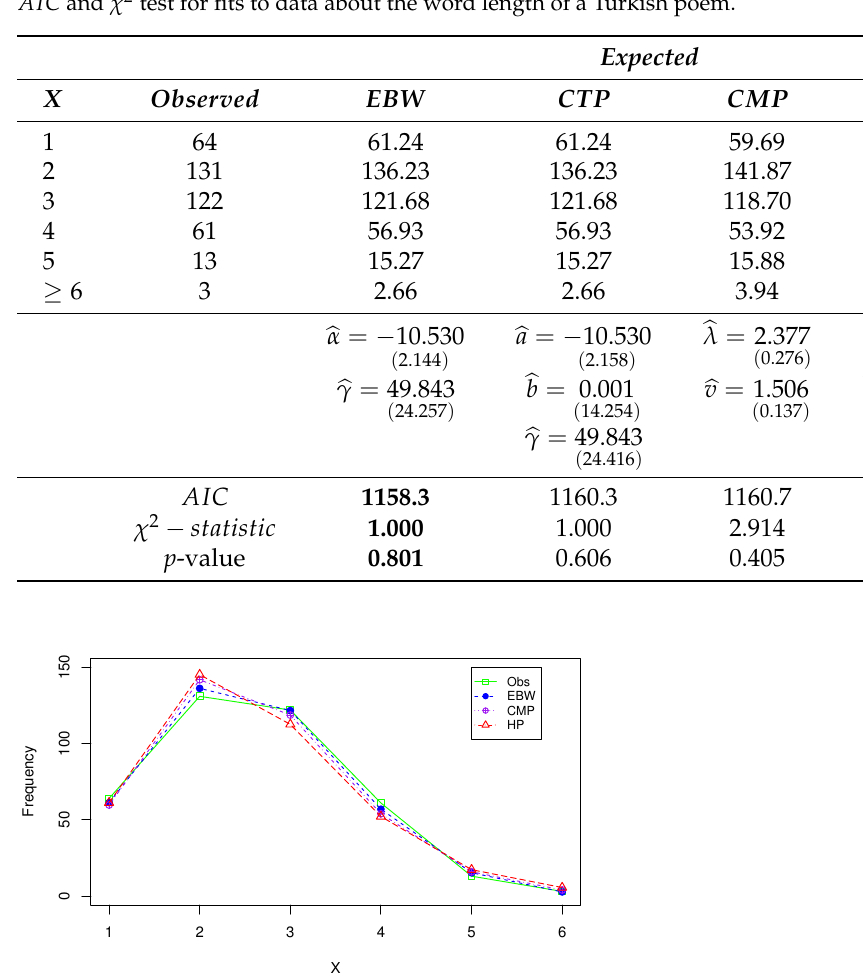
Figure 5. Observed and expected frequencies for data about the number of syllables of a Turk- ish